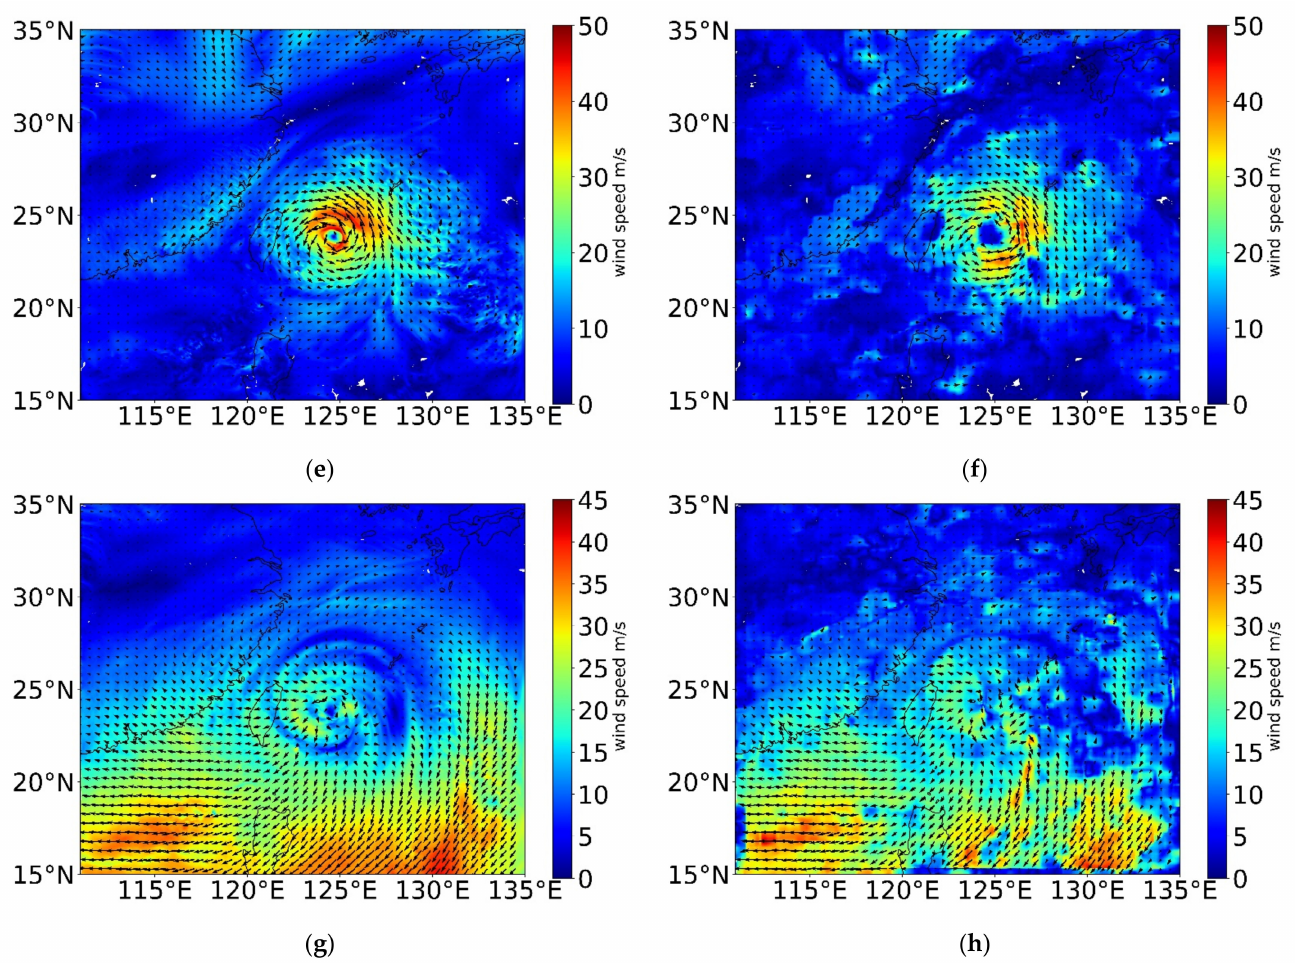
Figure 5. The WRF wind fields and OF wind fields of 850 ( a , b ), 500 ( c , d ), 300 ( e , f ), and 100 hPa ( g , h ) on 12:05 on 8 August 2019 (UTC). The satellite revisiting time is set to 5 min. FOV size is set to 3